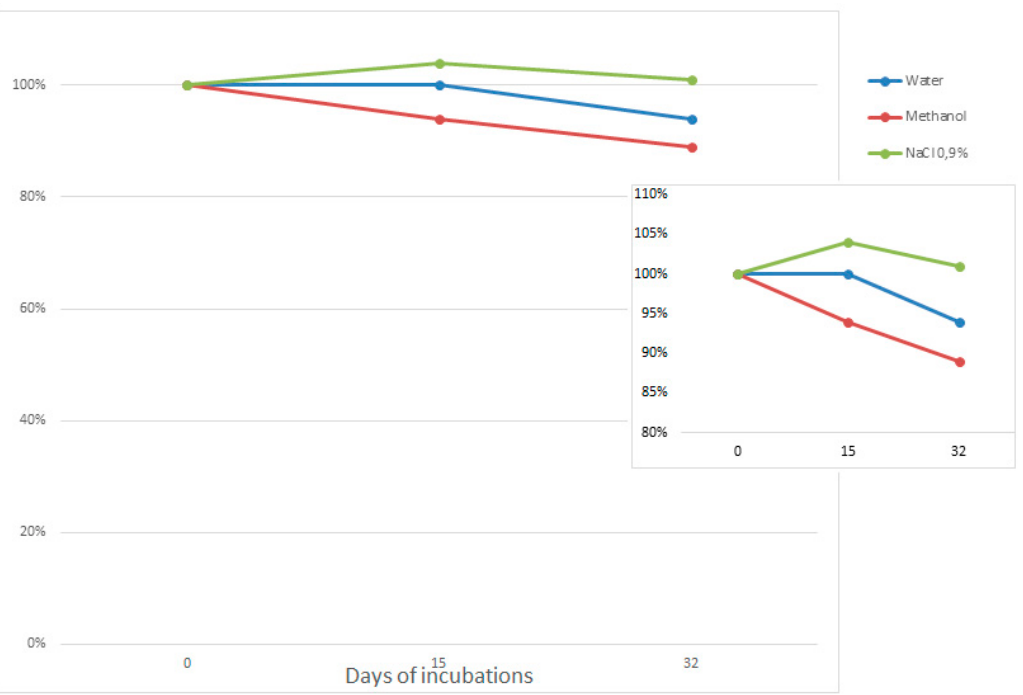
Figure 2. Normalized percentage of full antisense oligonucleotide (ASO) length over time for three solvents.